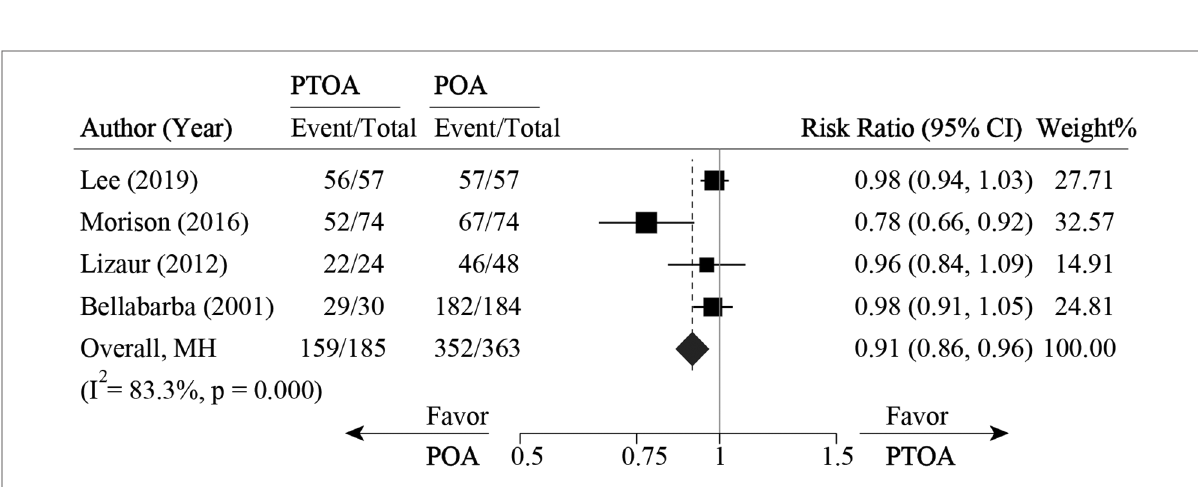
FIGURE 9 Pooled result for survival rate comparison between PTOA and POA. PTOA, post-traumatic osteoarthritis; POA, primary